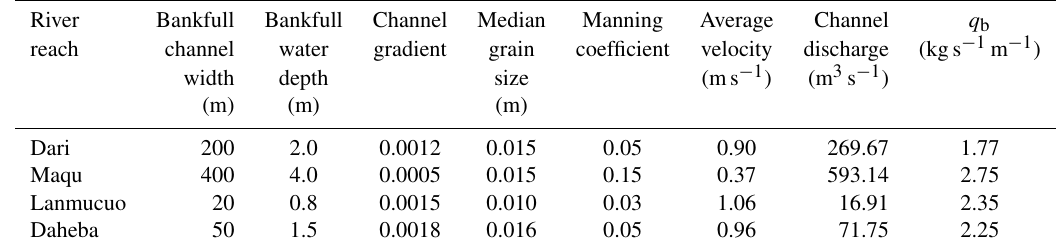
Table 3. Estimation of hydraulic coefficients and bedload transport rates. River Bankfull Bankfull Channel Median Manning Average Channel q b reach channel water gradient grain coefficient velocity discharge